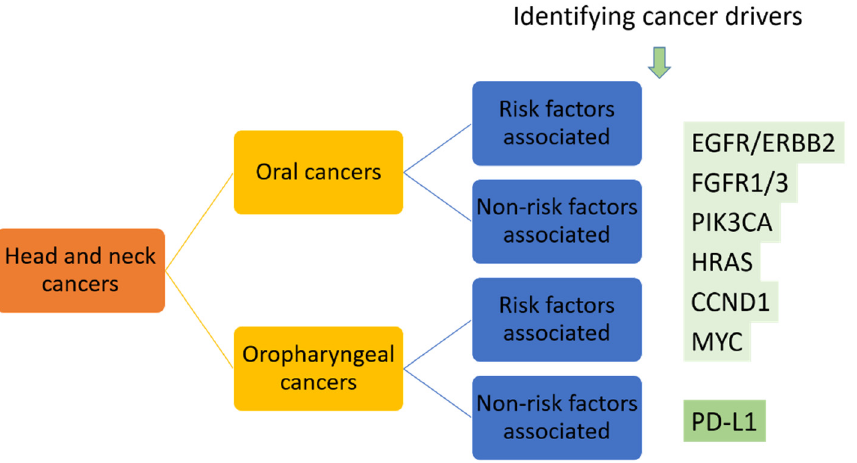
Figure 4. Proposed targeted therapy for head and neck cancers based on the identified druggable targets.